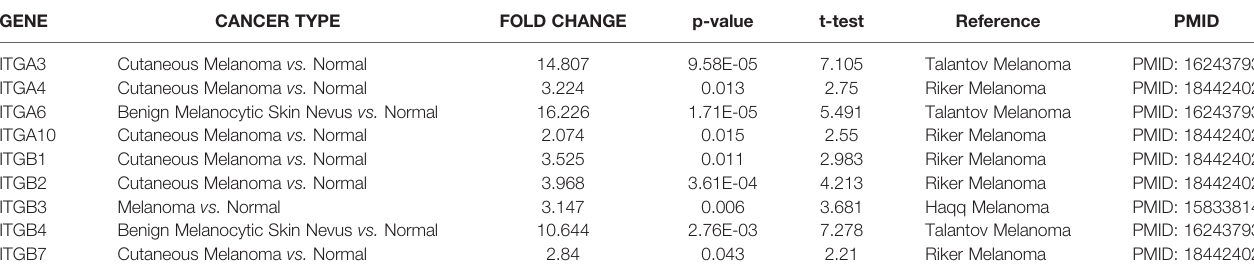
TABLE 1 | Aberrant expression of integrin subunits in SKCM patients. GENE CANCER TYPE FOLD CHANGE p-value t-test ITGA3 Cutaneous Melanoma vs.